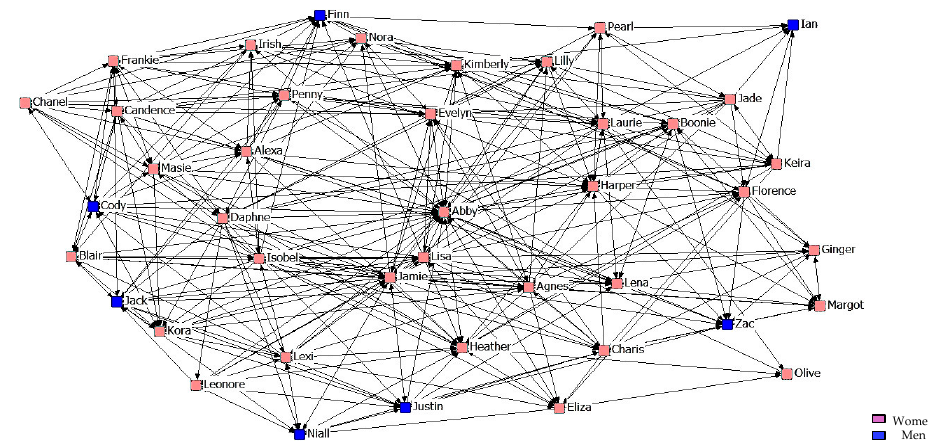
Figure 3. Graph of the third year Support Network.